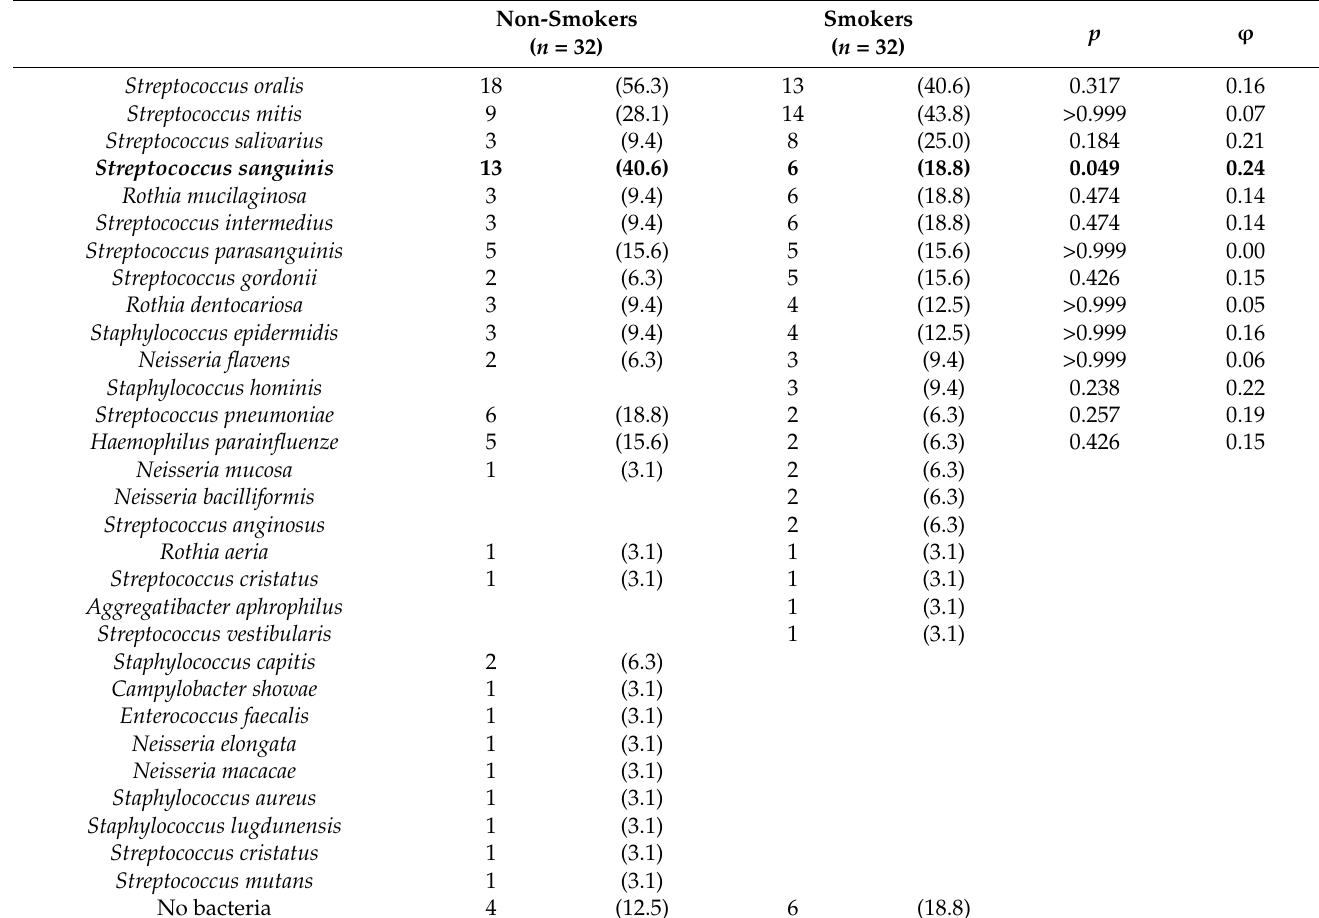
Table 4. Prevalence of aerobic